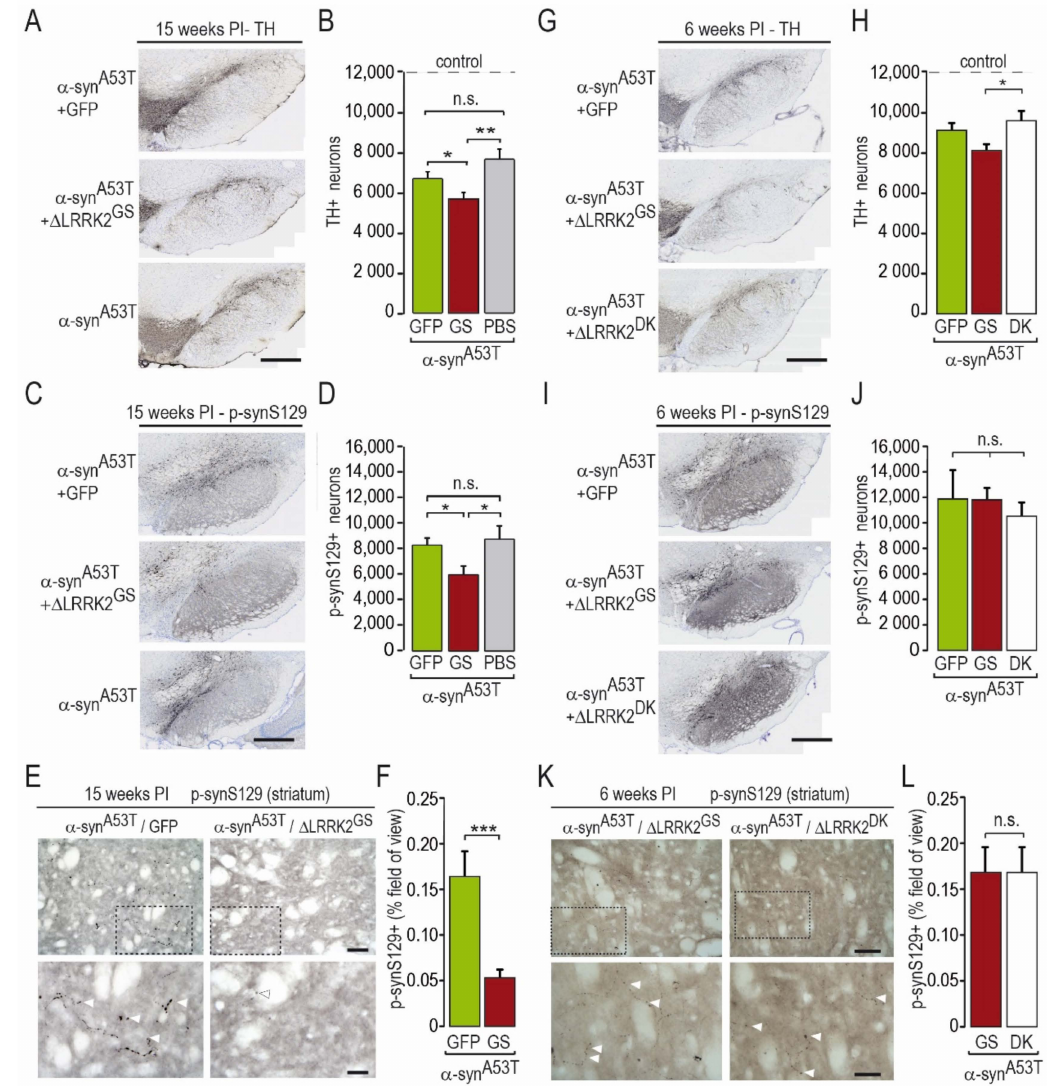
Figure 5. Immunohistochemistry for tyrosine hydroxylase (TH) and p-synS129-positive (p-synS129) cells and axons at 15 and 6 weeks post-injection. ( A – C ) Histological images and graphical quantification of TH-positive cells in the SNpc at 15 weeks PI ( A , B ) and 6 weeks PI ( G ,H). ( E – H ) Histological images and graphical quantification of p-synS129-positive (p-synS129+) neurons in the SNpc at 15 weeks PI ( C , D ) and 6 weeks PI ( I , J ). The number of TH-positive and p-synS129-positive cells was evaluated using unbiased stereology at very high magnification. ( I – L ) Histological images and graphical quantification of rat brain sections labeled by p-synS129 immunohistochemistry at the level of the striatum at 15 weeks PI ( E , F ) and 6 weeks PI ( K , L ) showing the presence of sparse positive objects with a necklace-like organization. The quantification was determined as the percentage of the field of view (area) occupied by p-synS129-positive staining. Results are expressed as the means ± SEM. N = 7–13 animals/group. ANOVA and PLSD post hoc test. * p < 0.05, ** p < 0.01, *** p < 0.001. Scale bars: 400 in ( A , C , E , G ) and 50 µ m in images in ( I , K